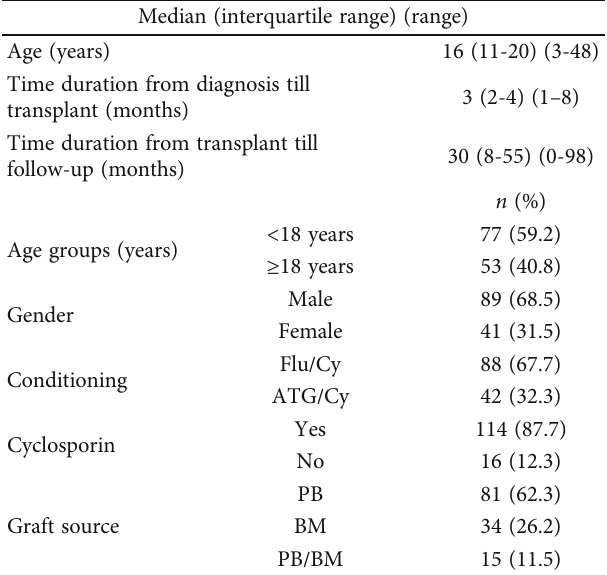
Table 1: Baseline characteristics of acquired aplastic anemia patients ( n = 130